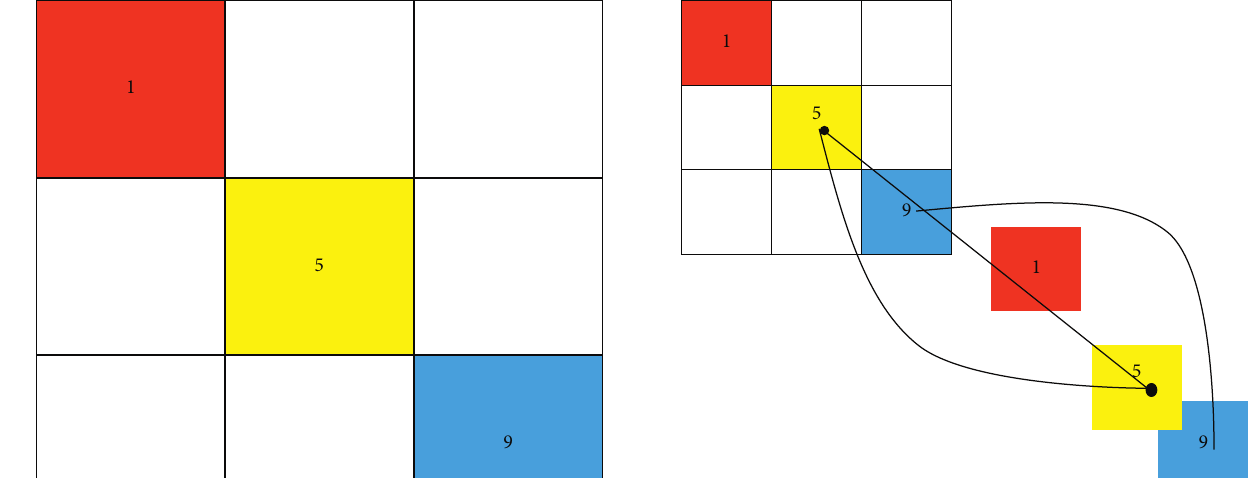
Figure 15: Schematic diagram of target tracking